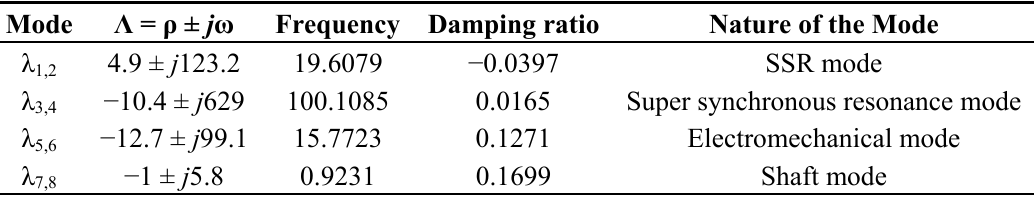
Table 1. System mode at 7 m/s wind speed with a 75% compensation